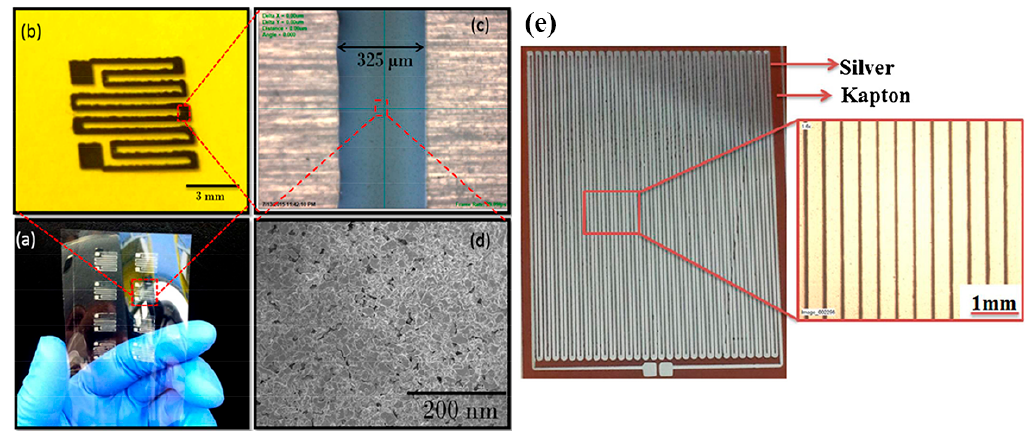
Figure 16. Ag-based temperature sensors: ( a – d ) a back-to-back topology for compensation of bending effects on temperature sensing (reproduced with permission from [59] copyright 2016, American Chemical Society); ( e ) Kapton-based inkjet-printed temperature sensor (reproduced with permission from [58] copyright 2016, Elsevier).